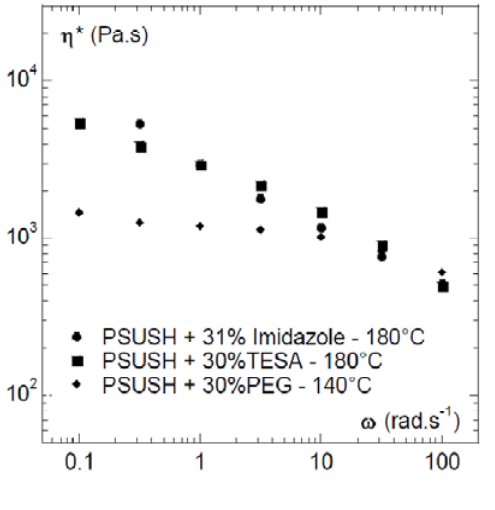
Figure 8. Effect of PEG, imidazole, TESA plasticizers on the viscosity of SPSFH (IEC = 1.35 H + /kg) blends.